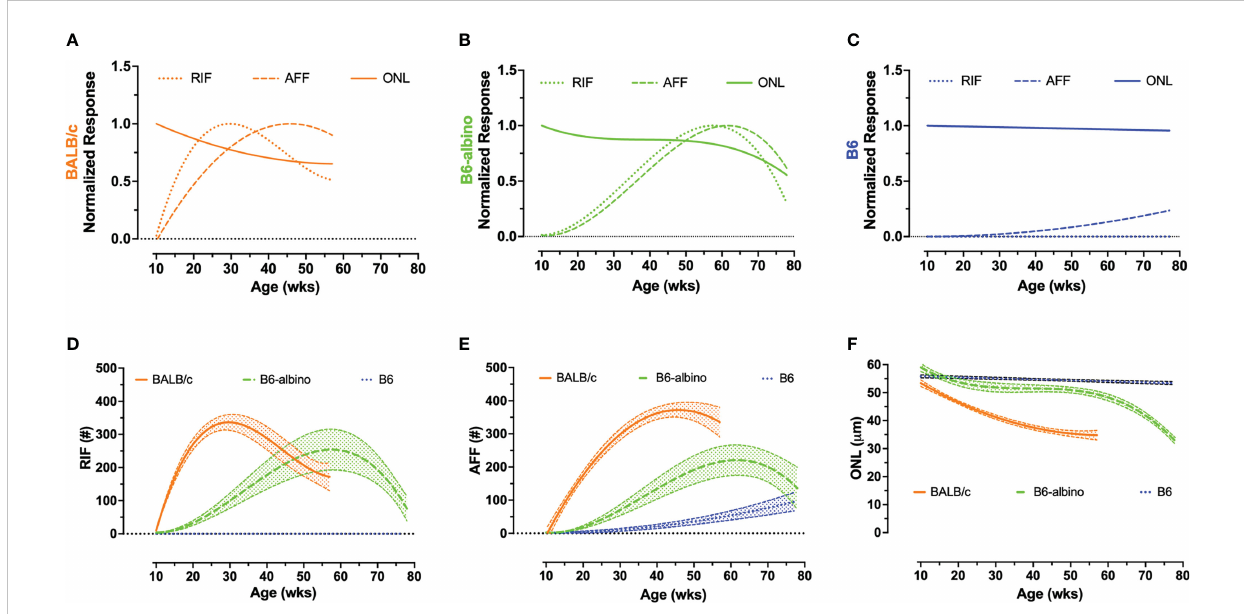
FIGURE 2 Intra- (A – C) and inter-strain (D – F) summary graphs showing the retinal dynamics of RIF, AFF and photoreceptor degeneration (ONL) in BALB/c, B6- albino and B6 mice. I ntra-strain biomarker comparisons of normalized mean dynamic trends for RIF, AFF, and photoreceptor (ONL) degeneration in BLE cohorts of BALB/c (A) , B6-albino (B) and B6 (C) mice. Inter-strain biomarker comparisons of non-normalized RIF (D) , AFF (E) , and photoreceptor (ONL) degeneration trends (mean count/thickness +/- CI) in BLE mouse